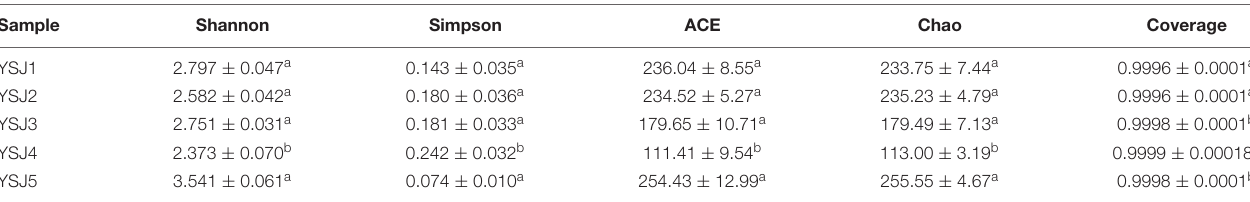
TABLE 2 | Endophytic community richness and diversity indices of A. zerumbet seeds. Sample Shannon Simpson ACE Chao